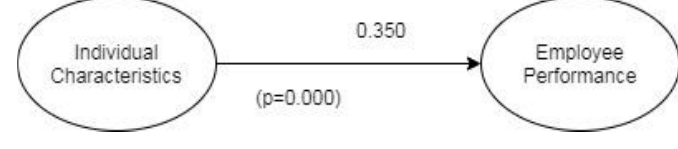
Figure 2: Direct Effect Testing Results; Source: Processed primary data, 2020